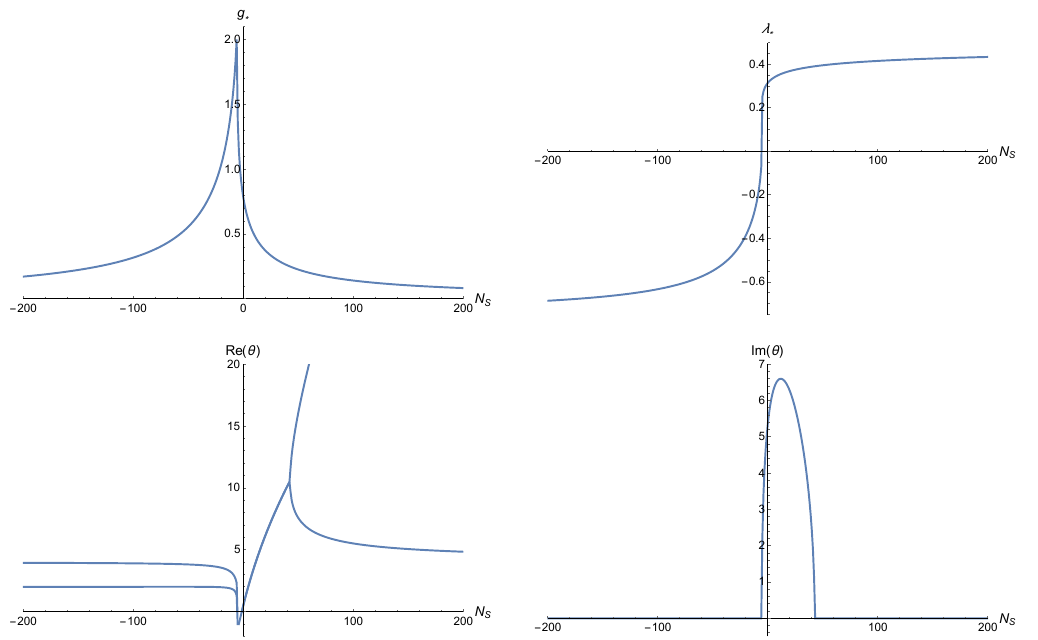
Figure 6 . Position (top) and stability coe(cid:14)cients (bottom) of the UV NGFPs appearing in gravity- scalar systems as a function of N S . The (cid:12)xed point structure undergoes qualitative changes at N S (cid:25) (cid:0) 6 and N S (cid:25) 46 where the critical exponents change from real to complex